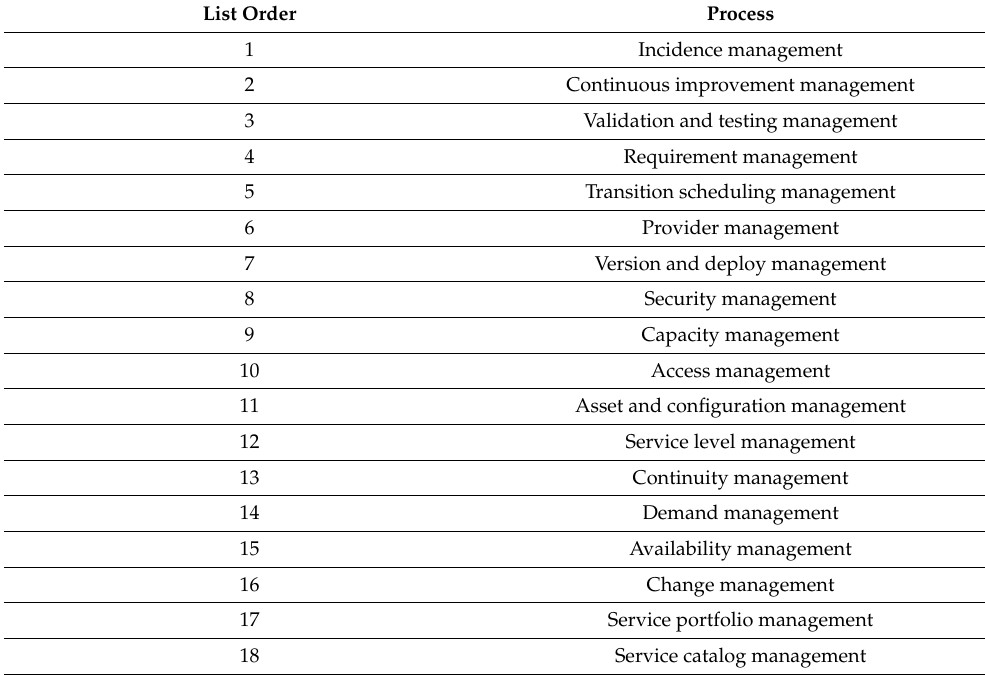
Table A3. Proposal of ordered list of ITIL processes for a representative tourism company. List